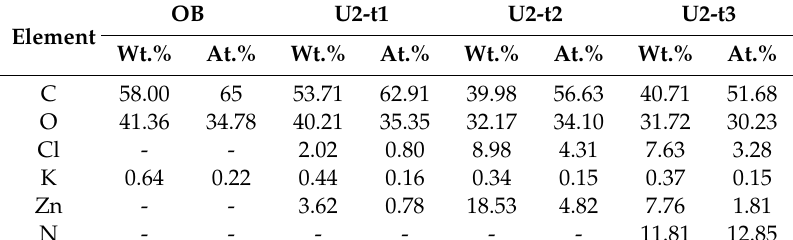
Figure 4. Energy-dispersive spectroscopy (EDS) of bamboo surface under with different treated time. Table 2. Surface element content of bamboo surface before and after treated.